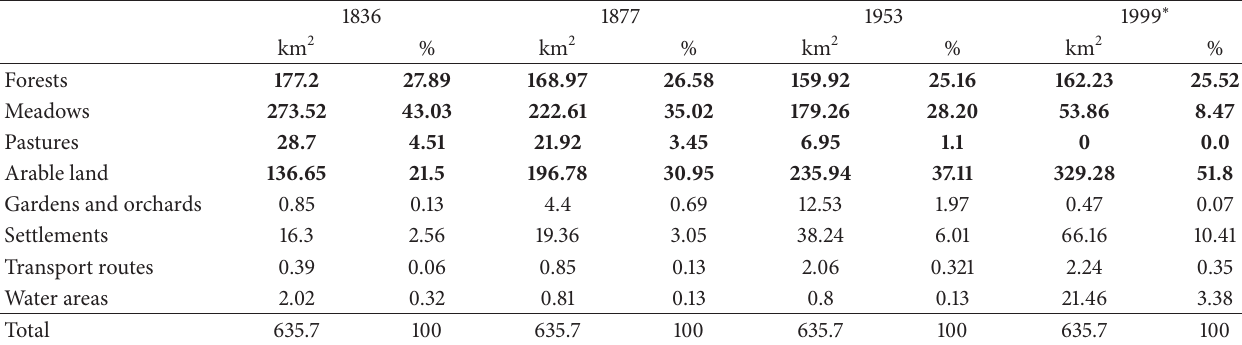
Table 1: Land use in the Morava River floodplain [5].